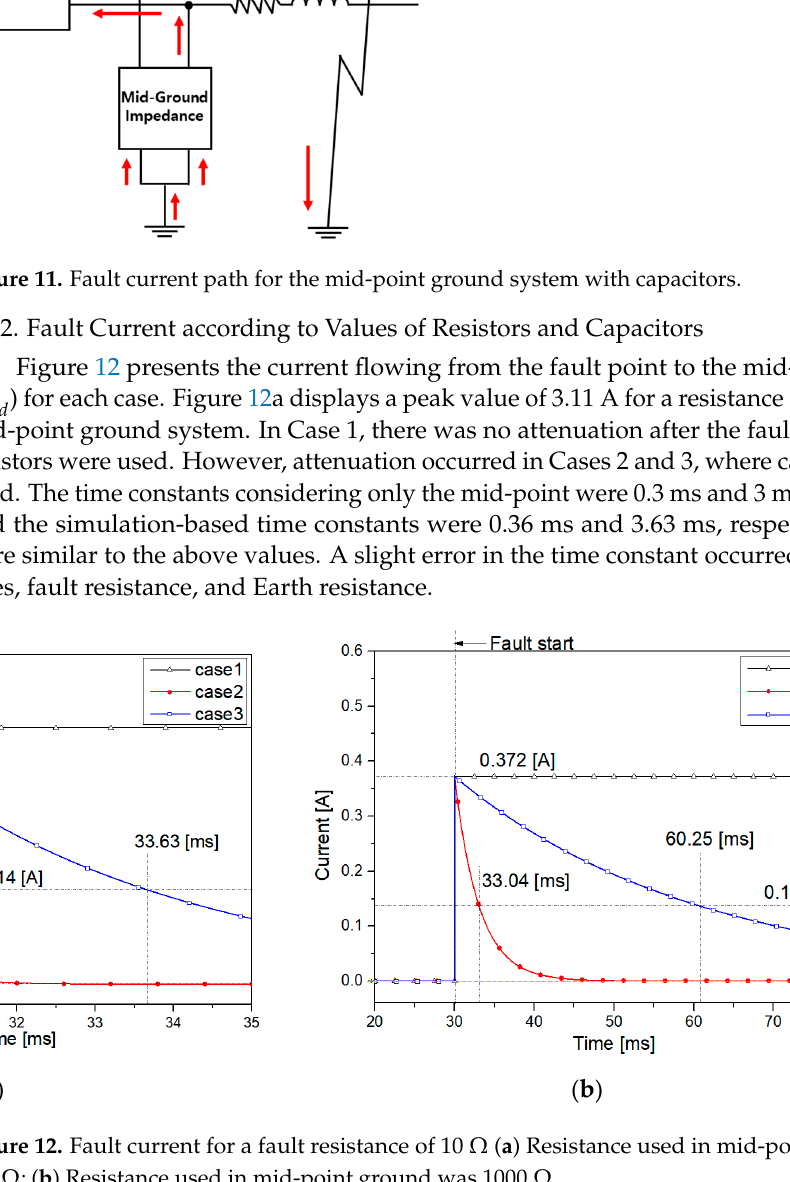
Figure 11. Fault current path for the mid ‐ point ground system with capacitors.